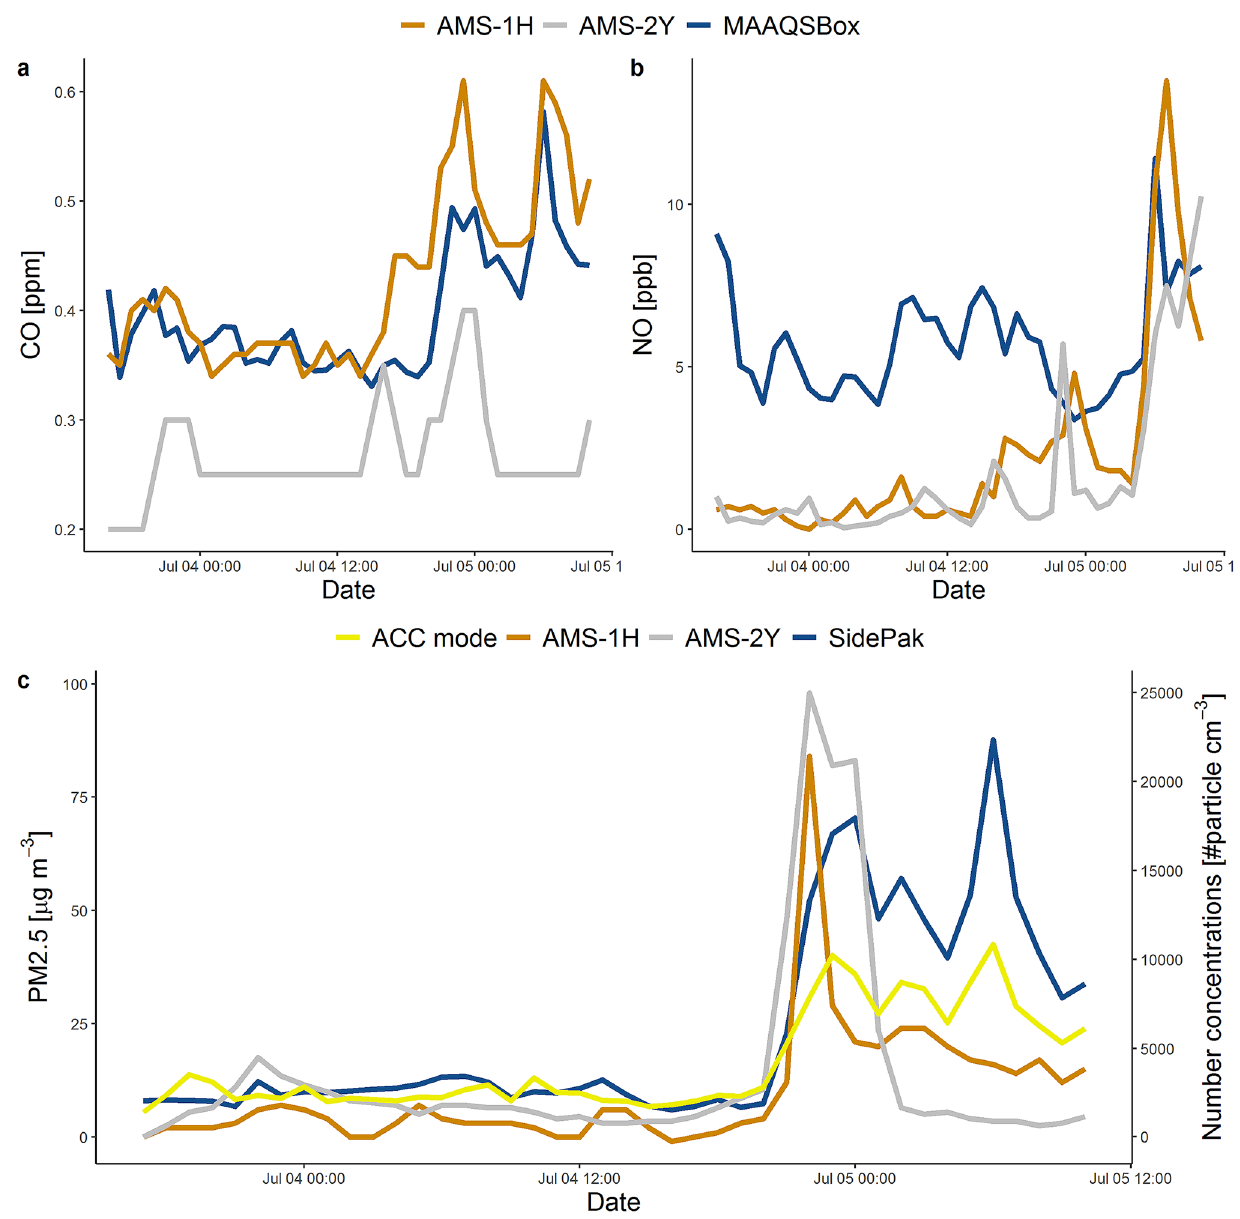
and the grey line is the previous 2-years average during same time Fig. 6 Fireworks and ambient air quality from July 3rd to 5th July. (AMS-2Y). Yellow line is the accumulation mode number concentra- a CO ppm, b NO ppb, c PM and number. The blue lines represent 2.5 tion. The data are hourly mean the data from MAAQSBox, the orange line is the data from AMS during the same time of MAAQSBox measurements (AMS-1H),